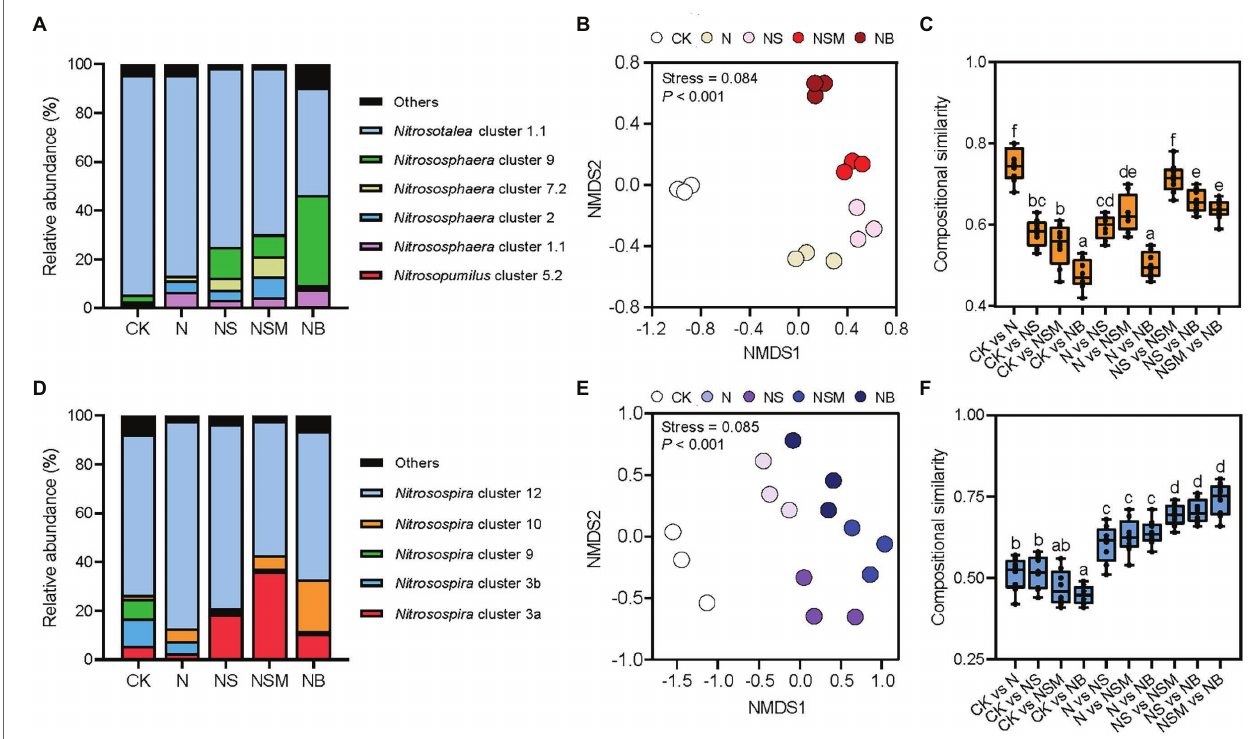
FIGURE 3 | The ammonia oxidizers under the five fertilization treatments. Taxonomic information of AOA (A) and AOB (D) populations are based on the amoA gene sequences. Non-metric multidimensional scaling (NMDS) analysis of AOA (B) and AOB (E) population structures based on the amoA gene. The pairwise compositional similarity of AOA (C) and AOB (F) population structures across five treatments. Different lowercase letters indicate significant differences based on Tukey’s HSD test ( p < 0.05). CK, no fertilizer; N, NPK fertilizer; NS, NPK fertilizer and straw; NSM, NPK fertilizer and straw combined with pig manure; NB, NPK fertilizer and straw